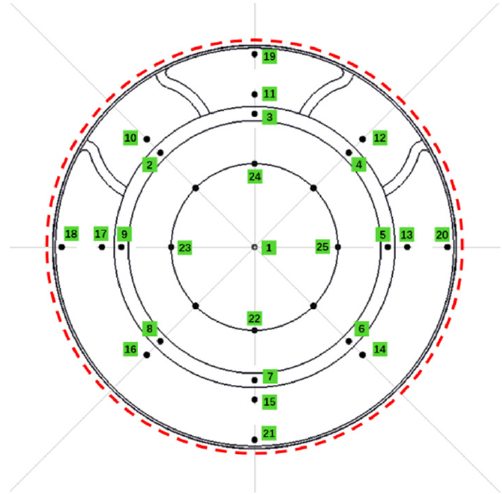
Figure 3. The distribution of the MPs in the combustion chamber.